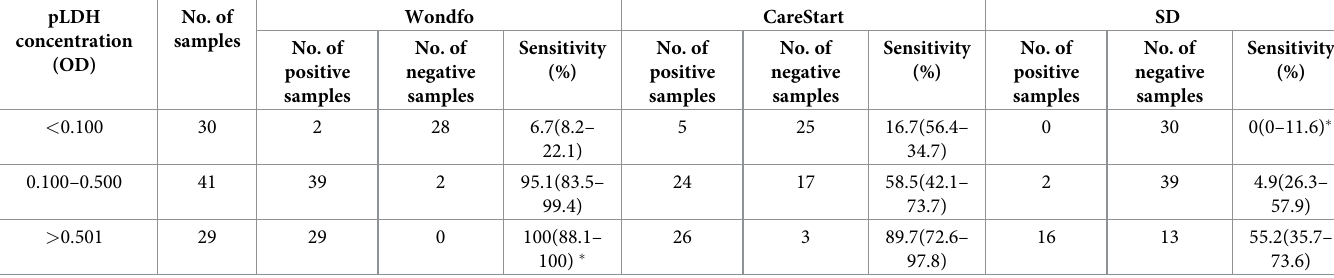
Table 5. Comparison of the sensitivity of the three RDTs in the detection of P . ovale categorized by pLDH concentration. pLDH No. of concentration samples (OD)